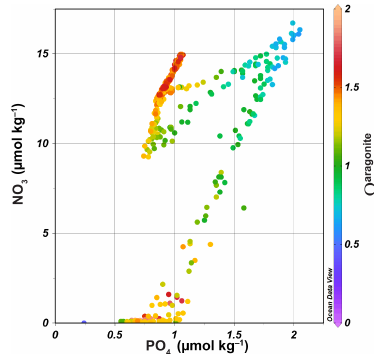
Figure 8. Nitrate versus phosphate as observed in the Canada Basin during the Beringia 2005 expedition (station locations same as in Fig. 4), colour-coded by (cid:127) aragonite